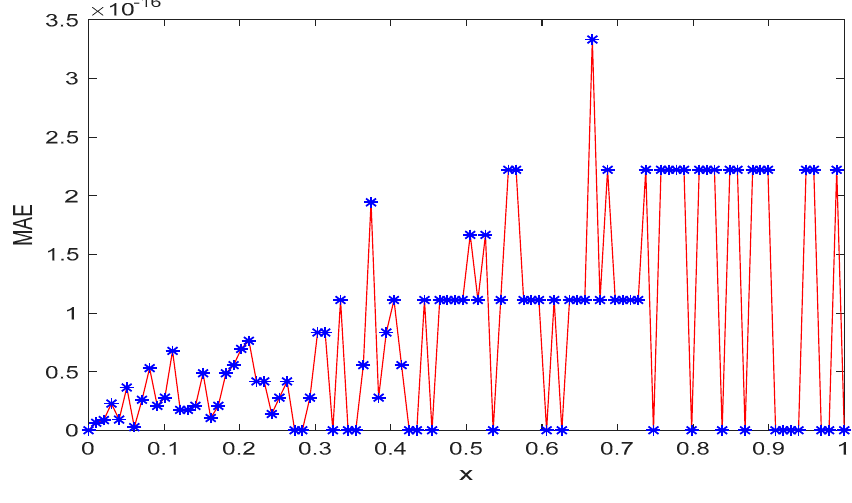
Figure 3. Plot of MAE of Example 2 for α = 1